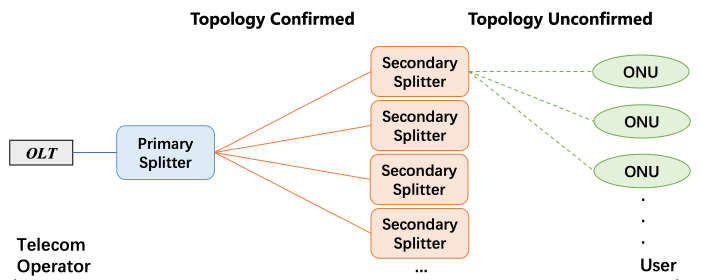
Figure 1. Topology of PON. OLTs are in factories of telecom operators while ONUs are in users’ rooms. The secondary splitter one ONU belongs to is registered, but not guaranteed due to passiveness and poor management. The higher level is